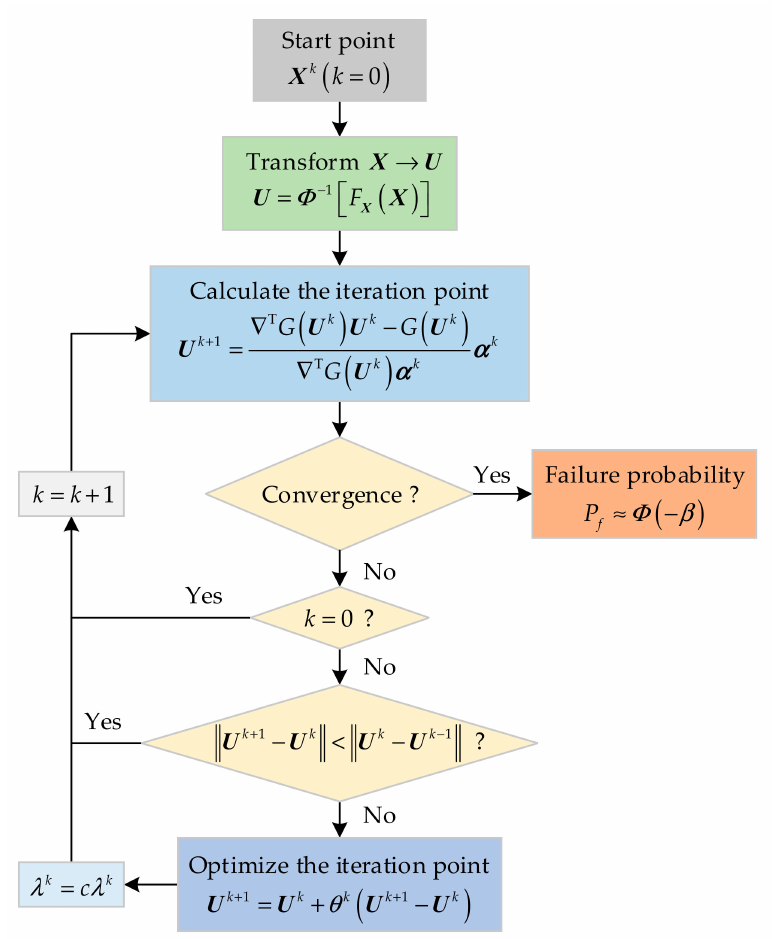
Figure 3. Framework of the proposed AFSL